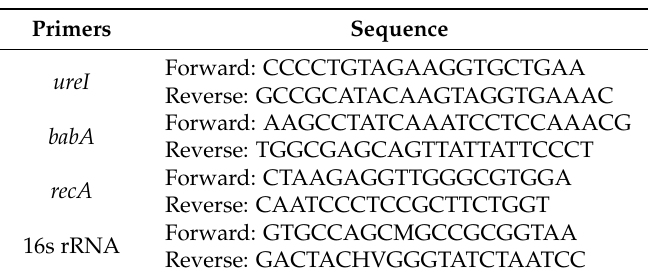
Table 4. The qRT-PCR primers used in this